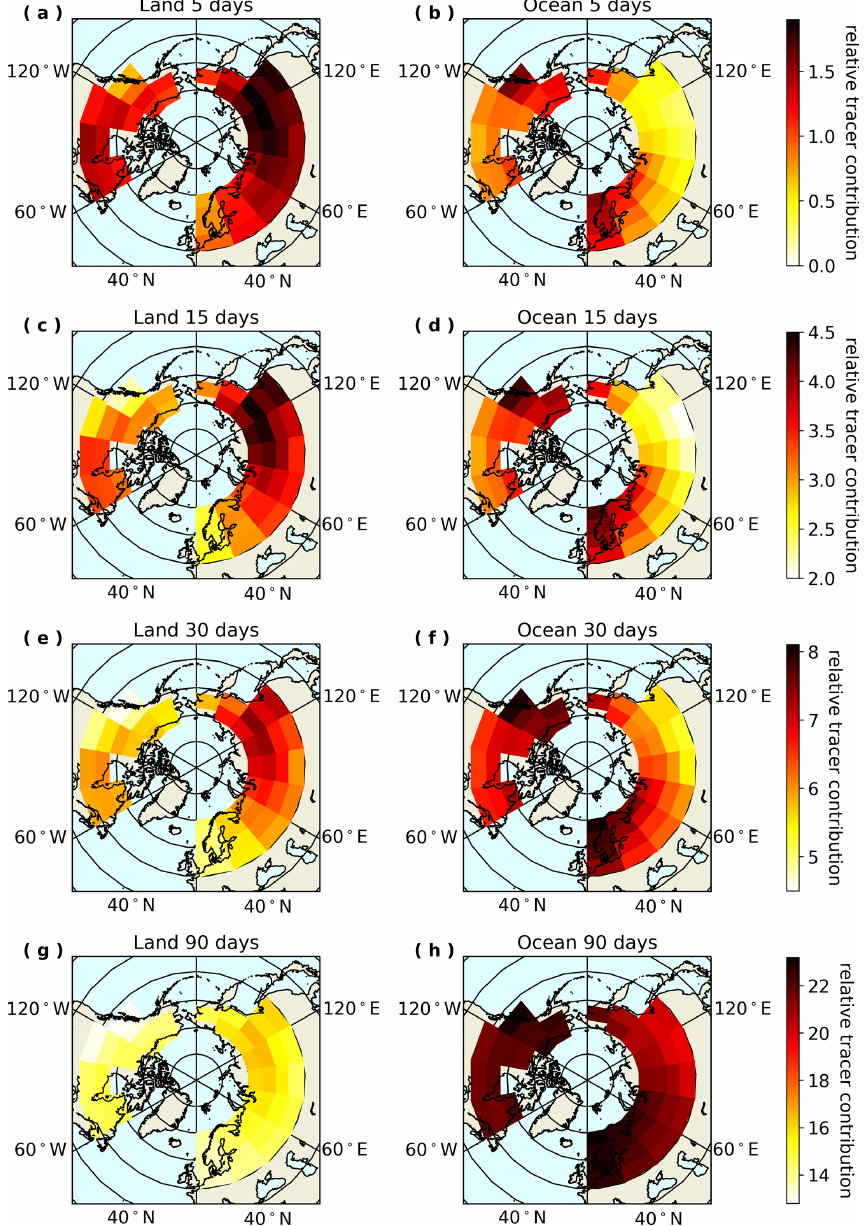
Figure 9. Maps of GEOS-Chem surface contact tracer contributions from land and ocean with 5, 15, 30, and 90d lifetimes for each zone, with units that are scaled relative to an arbitrary initial release of tracer particles. Surface contact tracer contributions shown here are calculated as an average of all days in the simulation period,